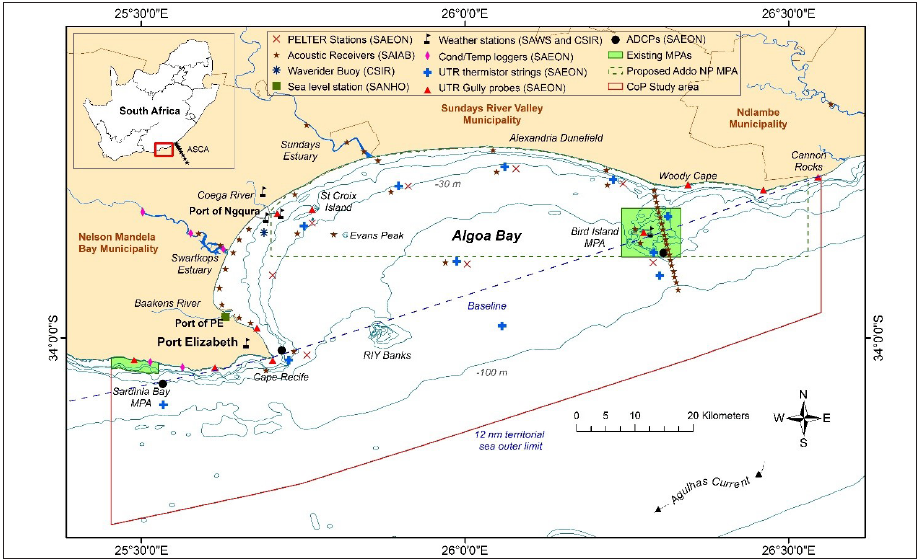
Figure 1: Map of the Algoa Bay Project study